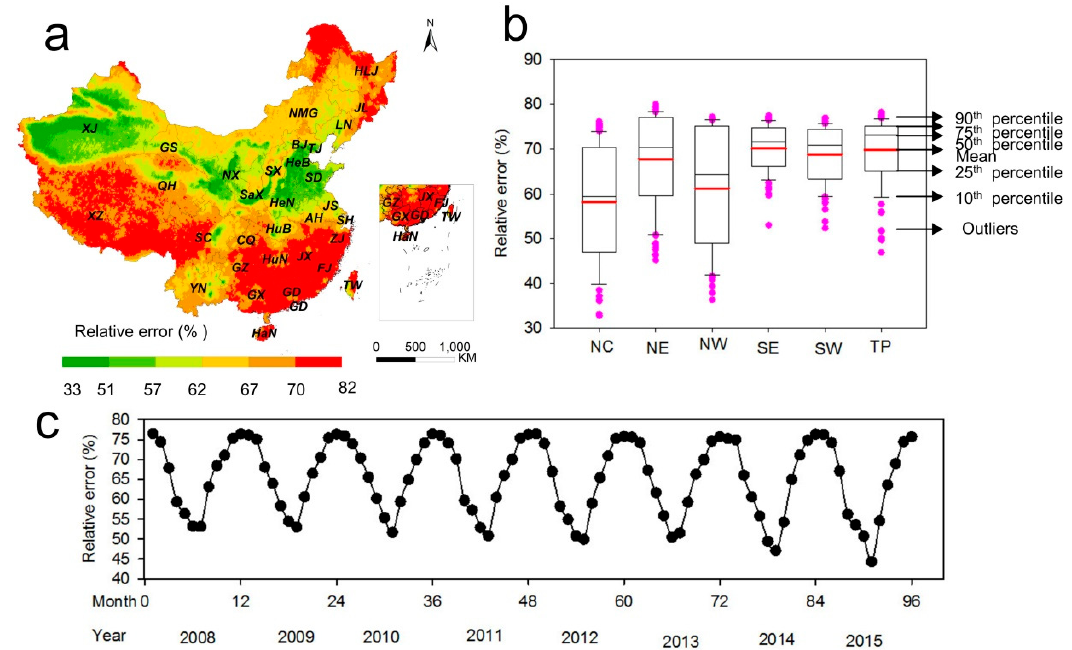
Figure A3. Relative error (%) of IASI NH 3 columns. ( a ) indicates the annual IASI NH 3 error (with a cloud coverage lower than 25%) averaged from 2008 to 2015; ( b ) indicates the averaged monthly relative error from 2008 to 2015 in different regions (every dot indicates the relative error at a month in a region); ( c ) indicates the temporal variations of relative error over China at a monthly scale.